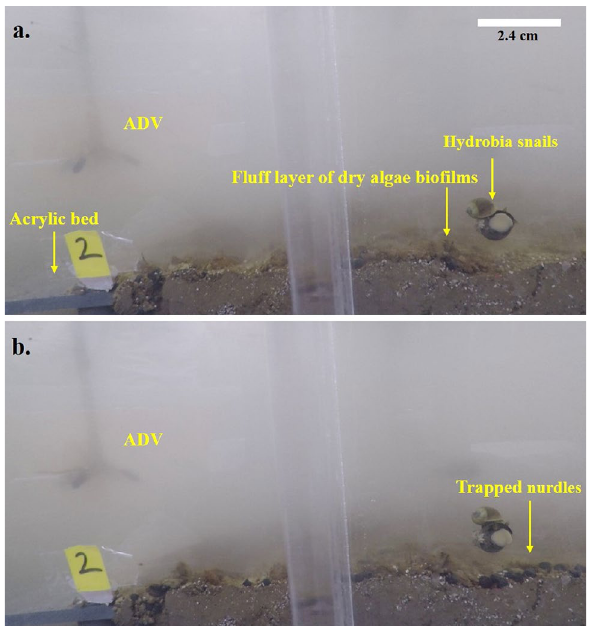
Figure 4. Trapping of the nurdles by the biogenic roughness from dry biofilm layer. Note the effect of depression on the bed surface in trapping the nurdles.